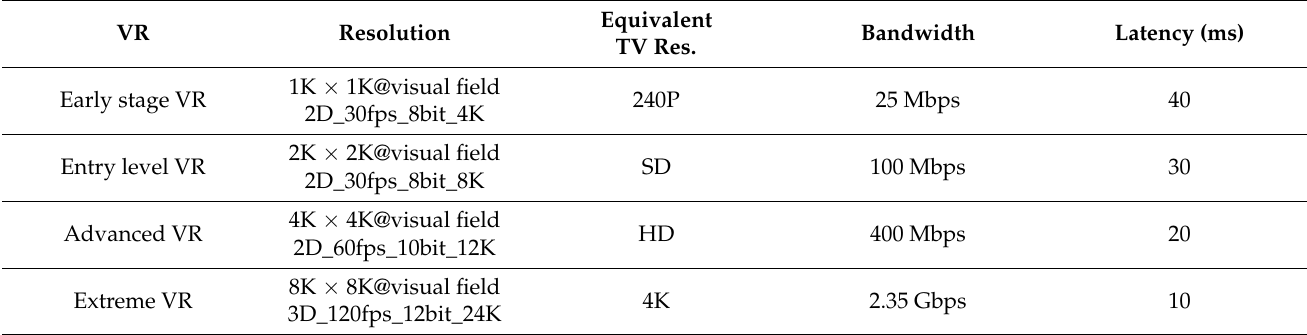
Table 1. Network requirement of VR.